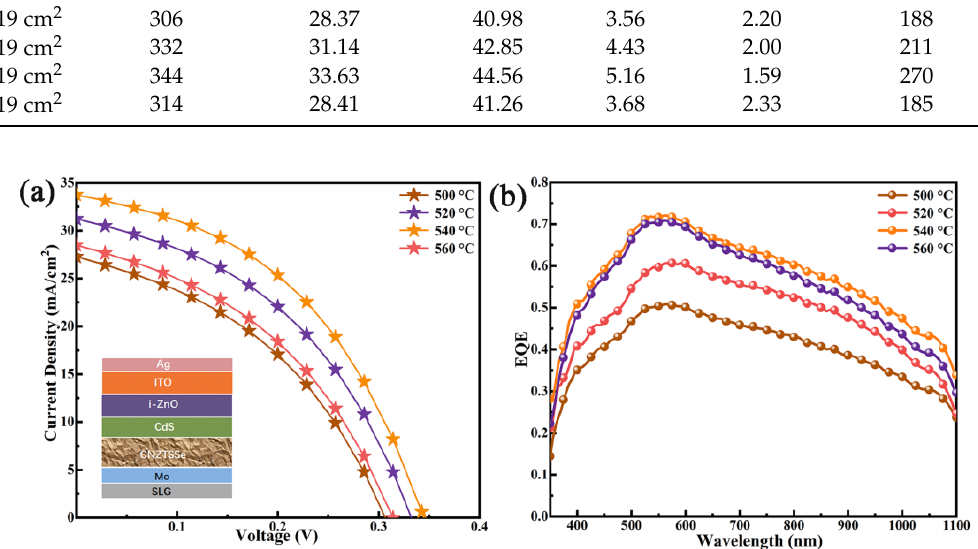
Figure 9. ( a ) Current–voltage characteristics of the CNZTSSe-based solar cells synthesized using the CNZTSSe absorber layer selenized at diverse temperatures of 500 °C, 520 °C, 540 °C, and 560 °C under AM 1.5G illumination; ( b ) EQE spectra of the corresponding CNZTSSe-based solar cells.